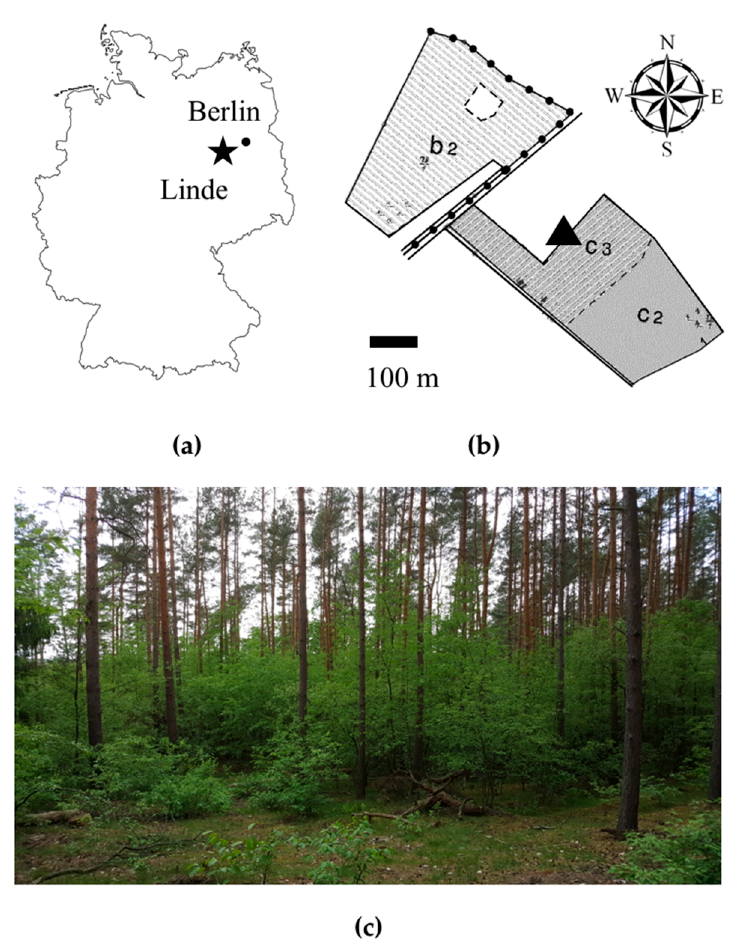
Figure 5. Study sites. ( a ) Location of Linde (star icon) as part of the federal state of Brandenburg. ( b ) Georeferenced forest map section with three study sites (b2, c3, c2). ( c ) Characteristic situation in the study area with established dense shrubby layers of Prunus serotina in the understory (date: 23.05.2017; place: stand c3, photo-location was labeled in Figure 5b).